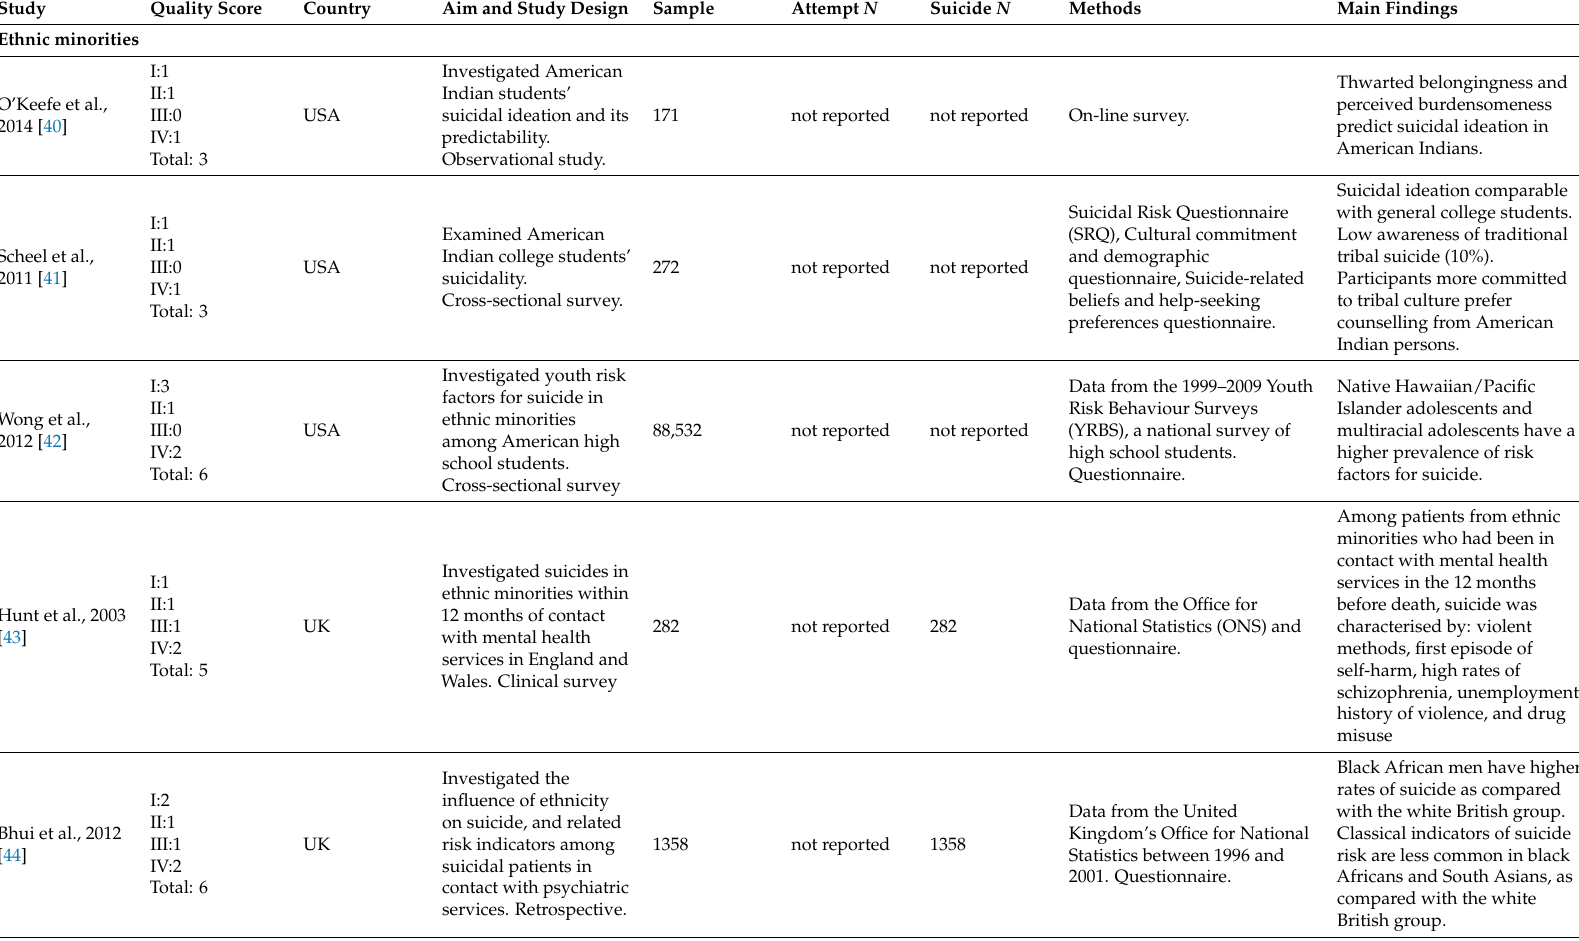
Table 1. Summary of reports on suicide risk in ethnic minorities and immigrants stratified by